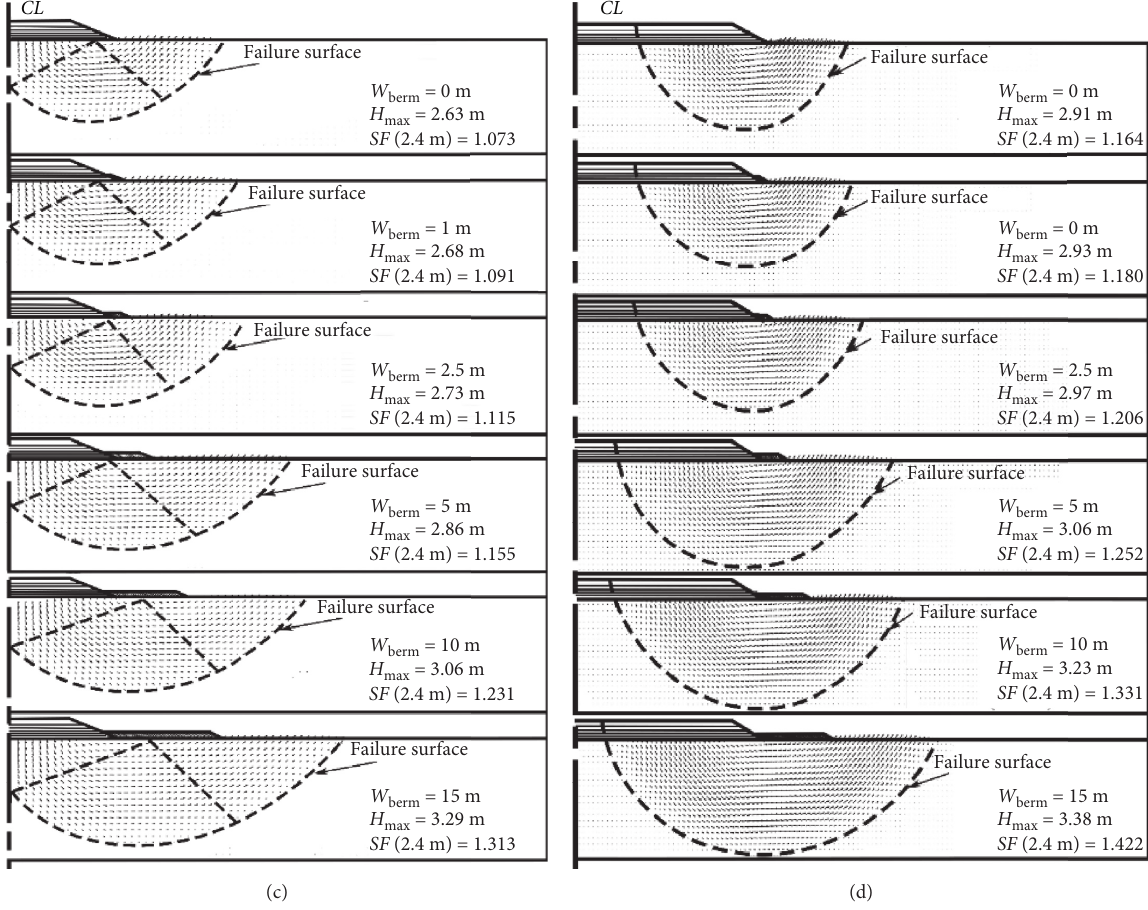
Figure 8: Effect of width of berms: (a) effect on limiting stack height; (b) effect on safety factor; (c) soil heaving mechanism with global failure mechanism; (d) soil heaving mechanism with local failure